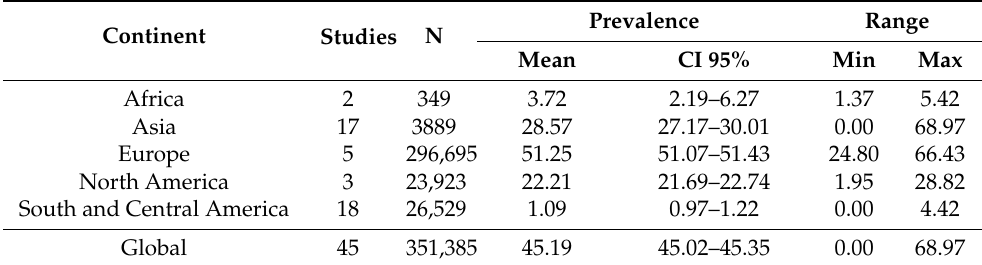
Table A3. Animal SLRV prevalence in each continent from 2001 to 2010.